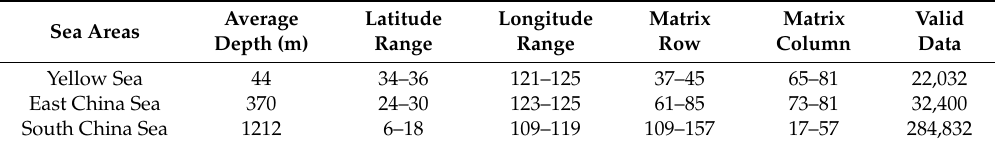
Table 1. The range of longitude and latitude grids of study areas and the corresponding data ranges.